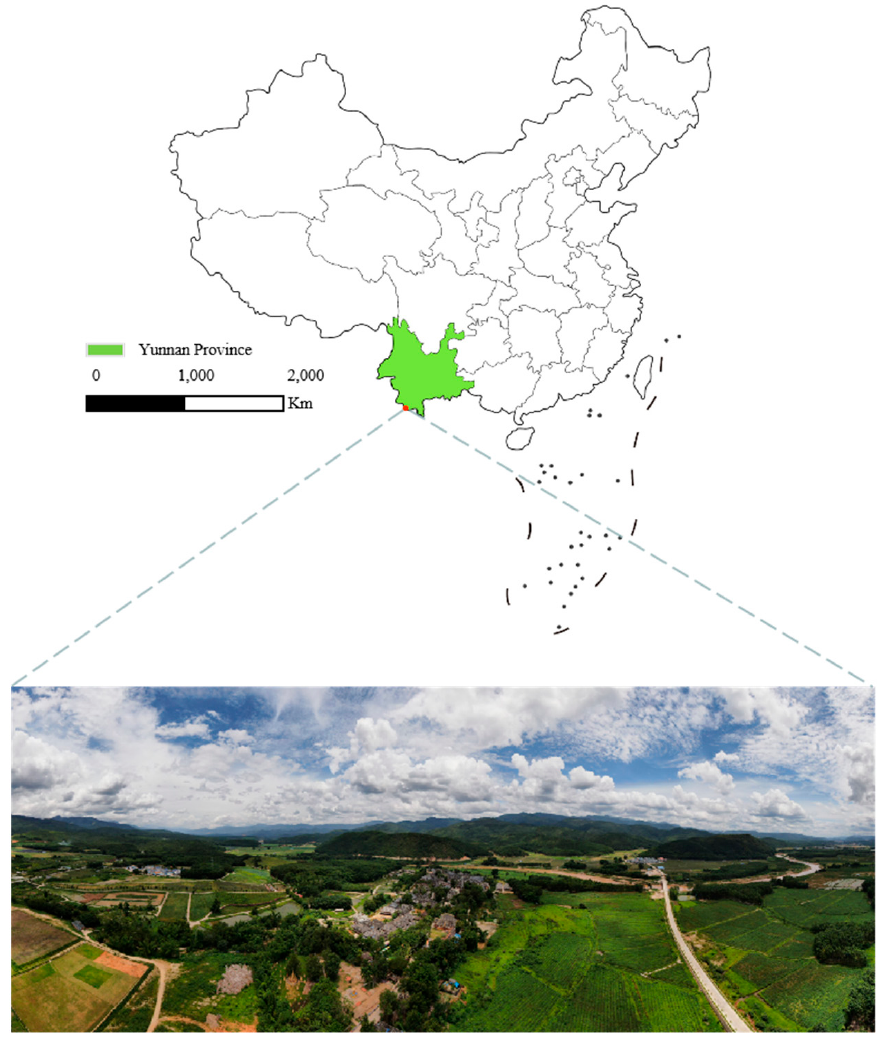
Figure 1. Location of Mengjinglai village in Yunnan, China.